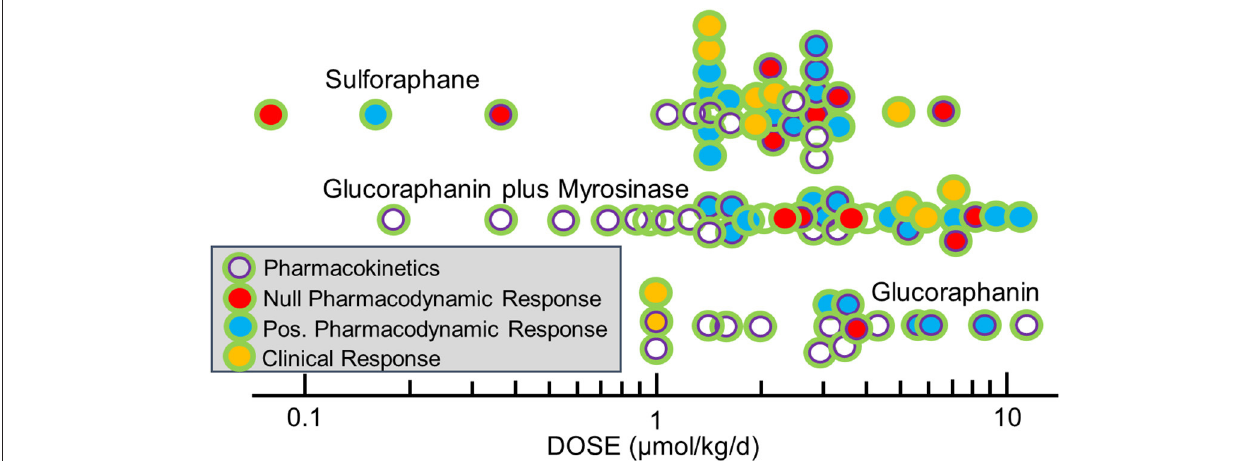
FIGURE 4 | Doses of glucoraphanin (GR)-rich, GR + myrosinase, or sulforaphane (SF)-rich broccoli sprout preparations used in clinical trials. Pharmacodynamic biomarkers included measures of NRF2 target genes, gene expression/function, inflammation, oxidative stress, carcinogenesis, and/or metabolomics. Doses were calculated as listed in Yagishita et al. ( 21) and outcome measures from classifications in Yagishita et al. (22).